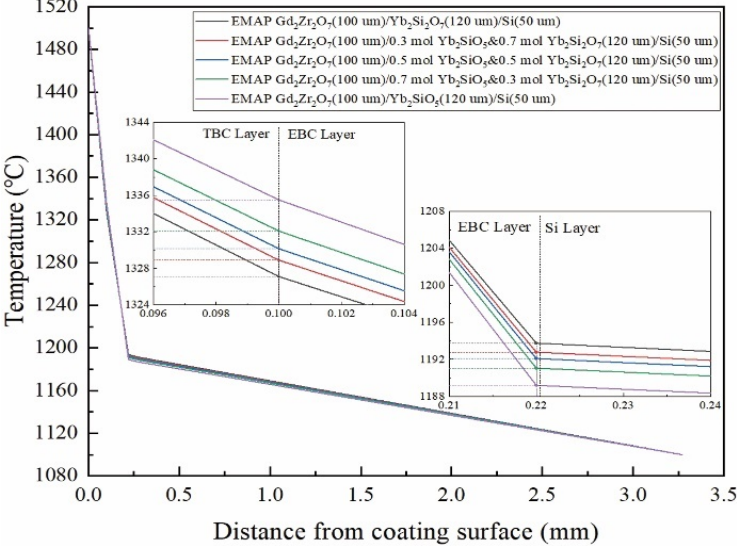
Figure 13. Effect of Yb 2 SiO 5 content on temperature distributions during heat preservation period.